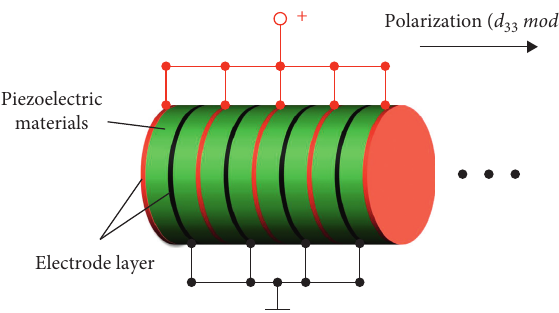
Figure 4: Schematic of the multilayer piezoelectric stack.